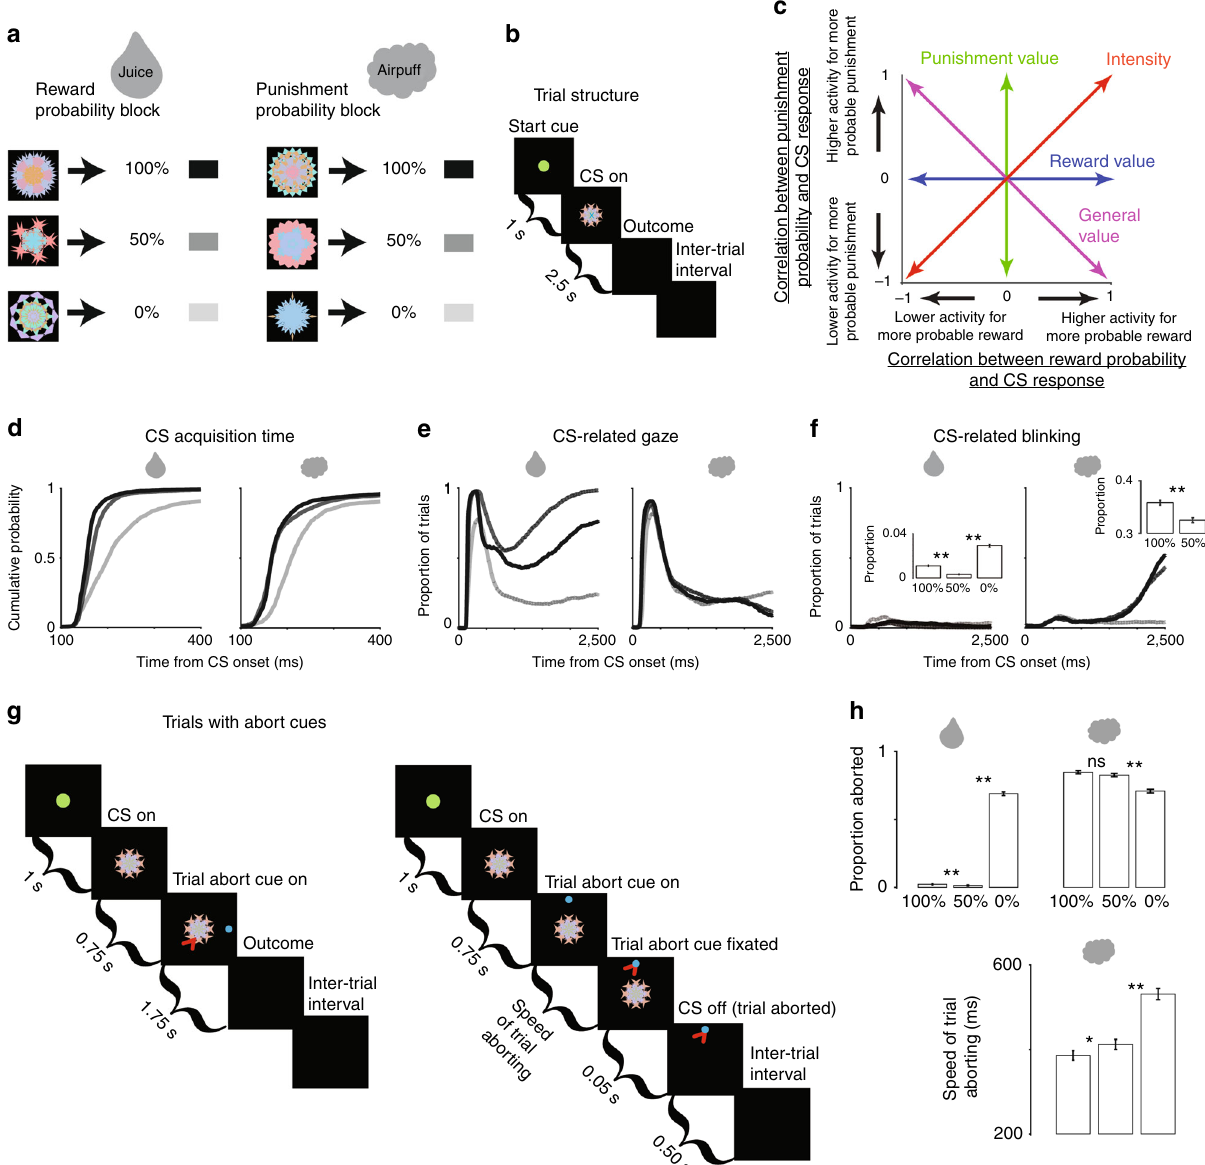
Fig. 1 The reward-punishment behavioral procedure. a Monkeys experienced two types of distinct blocks of trials in which three visual fractal-conditioned stimuli (CSs) predicted rewards and punishments with 100, 50, and 0% chance. The reward block consisted of 12 trials in which reward was possible, and the punishment block consisted of 12 trials in which punishment was possible. b Structure of a single trial. CS could appear in the center (as shown) or peripherally, 10 degrees to the left or right of center. c Theoretical valence-coding strategies in the reward-punishment procedure. d – f Monkeys ’ behaviors were motivated by reward, punishment, and uncertainty. d Cumulative probability functions of peripheral-CS gaze acquisition time. In reward or punishment block, the speed of CS acquisition was correlated with outcome probability (Spearman ’ s rank correlations; p < 0.01). e Proportion of trials the monkeys oriented to the location of peripheral CSs shown across the entire CS epoch for reward-block and punishment-block trials. During the last 1000 ms of the trial, the monkeys ’ gaze was preferentially attracted to the 50% reward CS ( p < 0.01; rank sum test). f Proportion of trials the monkeys blinked shown across the entire CS epoch for reward-block and punishment-block trials. Insets show mean proportion of time monkeys blinked during the last 500 ms of the CS epoch. g In distinct blocks we included an abort cue during approximately one half of the trials (Methods). Structure of trials with an abort cue. ( g , left ) — trials in which the monkeys did not abort (eye position is schematized by the red arrow); ( g , right ) — trials in which the monkeys aborted the trial. h Proportion of trials aborted in the reward block ( top-left ) and punishment block ( top-right ). The speed of trial aborting decreased with increasing punishment probability ( bottom ). The black – gray color legend for d – f are de fi ned in a . Error bars indicate standard error. Single asterisks indicate signi fi cance at a 0.05 threshold and double asterisks indicate signi fi cance at 0.01